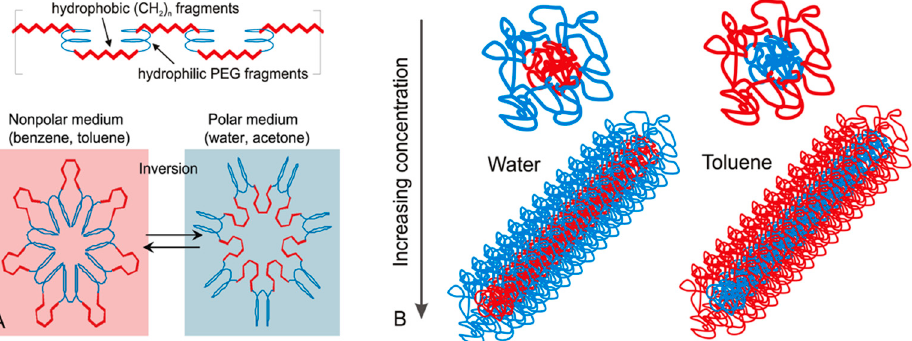
Figure 1. Amphiphilic invertible polymer and micelle structures ( A ) and micellar self-assembly ( B ) in polar and nonpolar solvents (reprinted with permission from [128]. Copyright 2011, American Chemical Society).